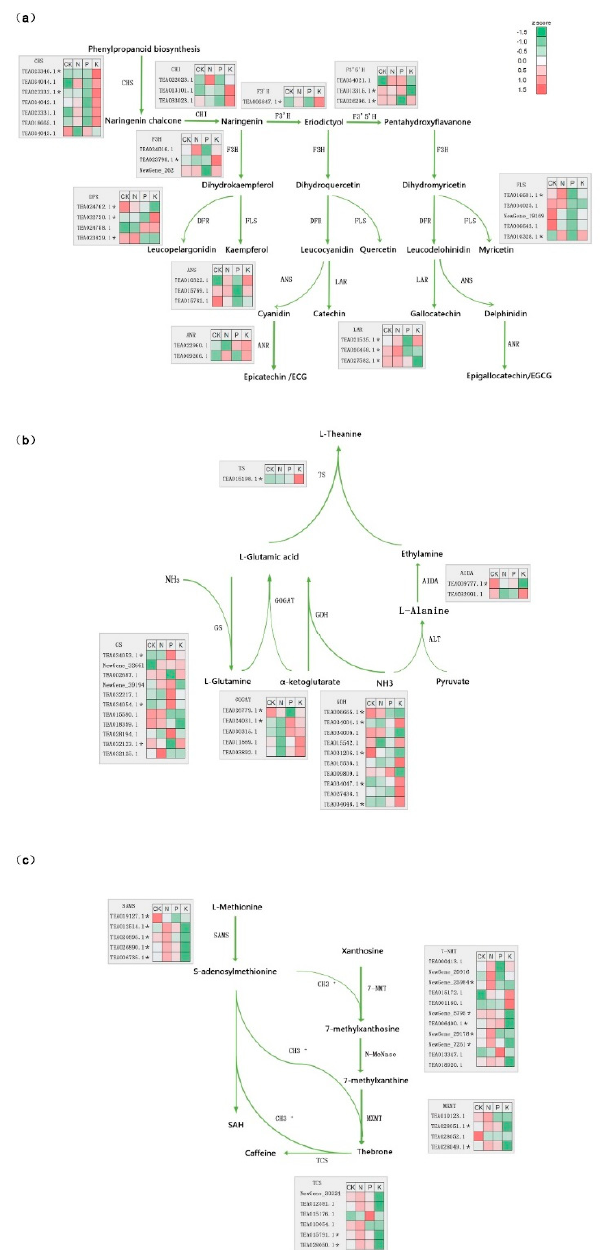
Figure 5. The expression of genes in biosynthesis pathway of catechins, theanine, and caffeine under N, P, and K starvation. ( a ) The expression of genes in the catechins, biosynthetic pathway. CHS, CHI, F3H, F3 ′ H, F3 ′ 5 ′ H, DFR, FLS, ANS, LAR, and ANR indicate genes encoding chalcone synthase, chalcone isomerase, flavanone 3-hydroxylase, flavonoid 3 ′ -hydroxylase, flavonoid 3 ′ ,5 ′ -hydroxylase, dihydroflavonol 4-reductase, flavonol synthase, anthocyanidin synthase, leucoanthocyanidin reductase, and anthocyanidin reductase, respectively. ( b ) The expression of genes in the L -theanine biosynthetic pathway. GS, GOGAT, GDH, TS, AIDA, and ALT represent glutamine synthetase, glutamate synthetase, glutamate dehydrogenase, L-theanine synthetase L -arginine decarboxylase, and alanine transaminase, respectively. ( c ) The expression of genes in the caffeine biosynthetic pathway. 7-NMT, MXMT, TCS, SAMS and SAH indicate xanthosine methyltransferase, theobromine synthase (7-methylxanthine methyltransferase), caffeine synthase (3,7-dimethylxanthine methyltransferase). S-adenosylmethionine synthetase, and S-adenosylhomocysteine, respectively. * refers to the differentially expressed genes among these macronutrient nutrient starvation.